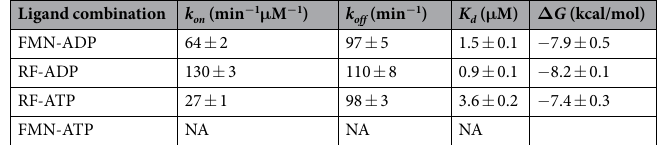
Table 2. Pre-steady-state kinetic parameters for the binding and dissociation of flavins to the RFK module in the presence of adenine nucleotides. Experiments were carried out in 20 mM PIPES and 0.8 mM MgCl 2 , pH 7.0. NA, not